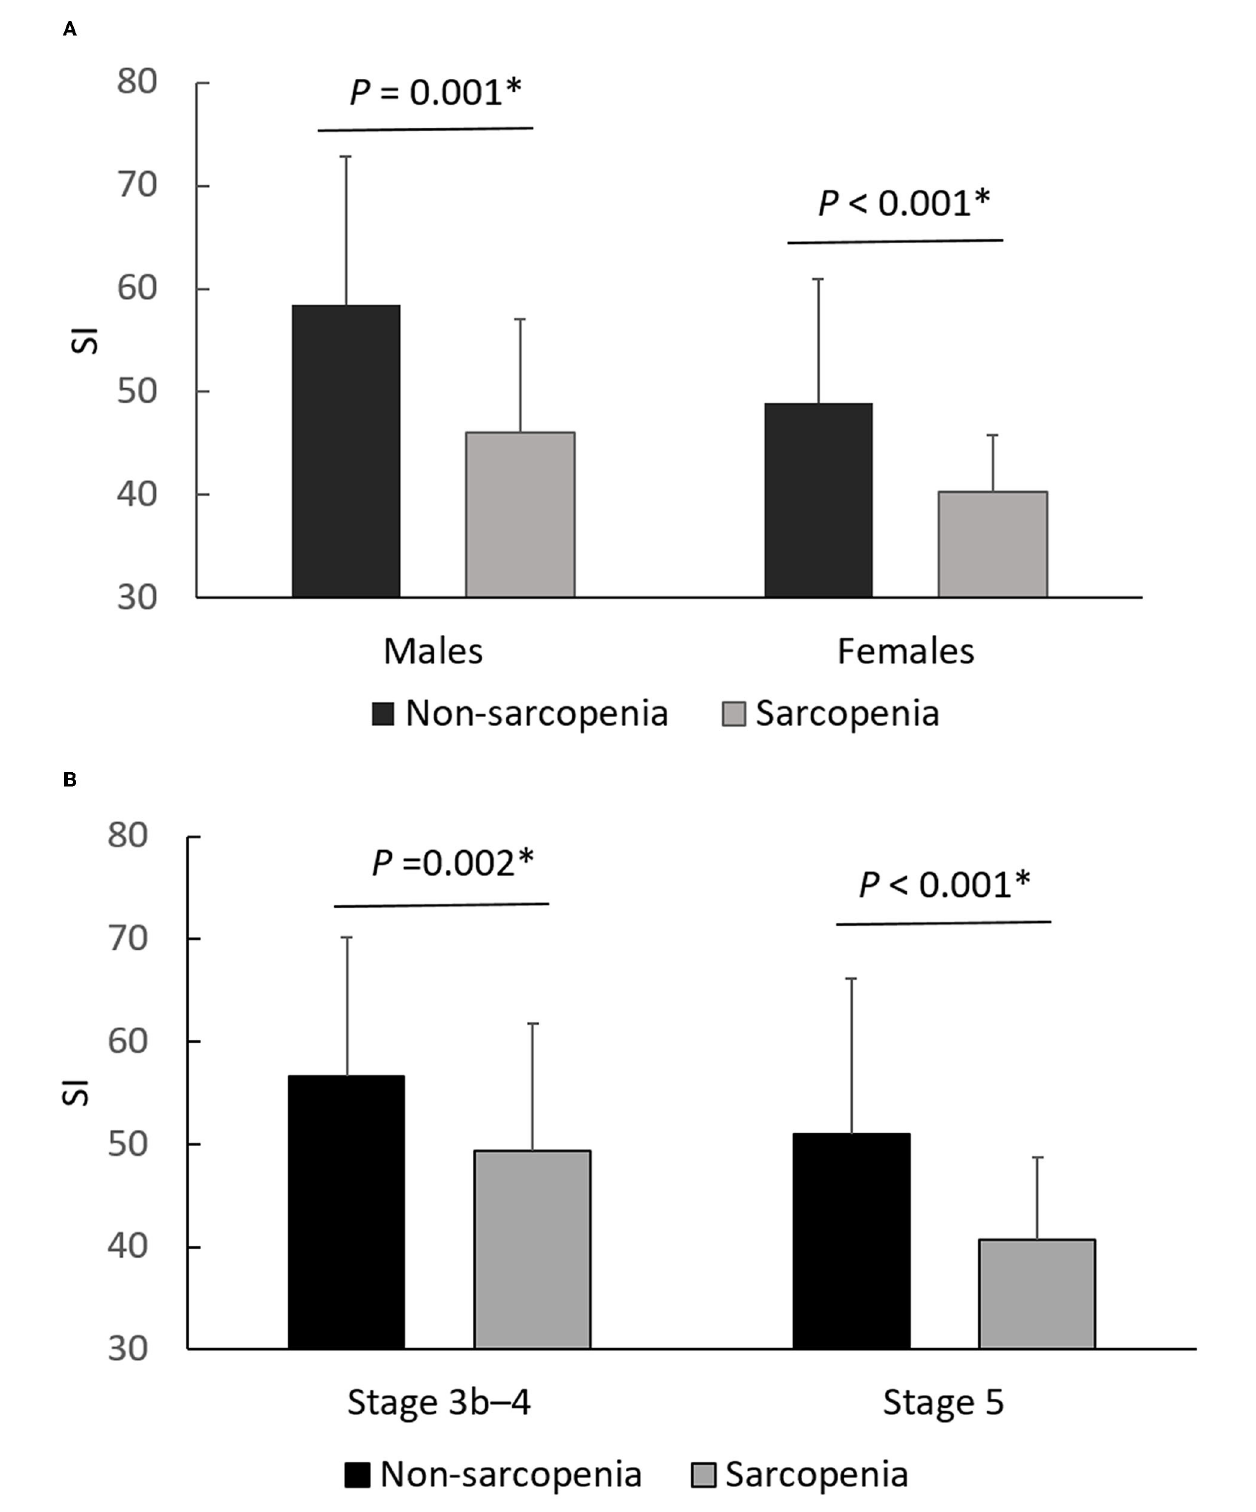
FIGURE 1 | Differences of SI between non-sarcopenia and sarcopenia, stratified by gender (A) and CKD stage (B) . * P < 0.05 was considered statistically significant.